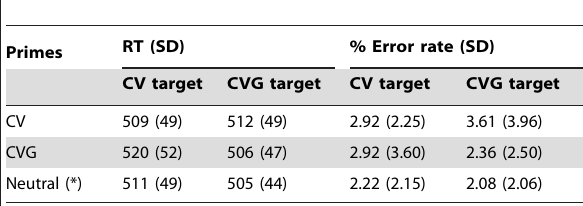
Table 1. Mean naming latencies (in ms) and mean percentage of errors (%) with standard deviation in parentheses in Experiment